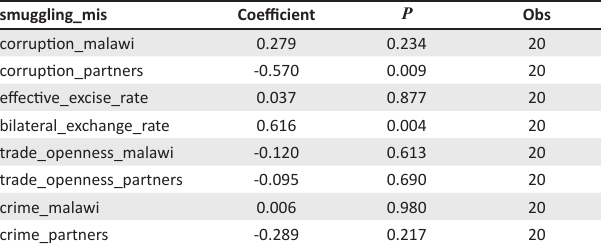
TABLE 5: Results from correlation analysis using Smuggling (MIS) as the indicator of cigarette